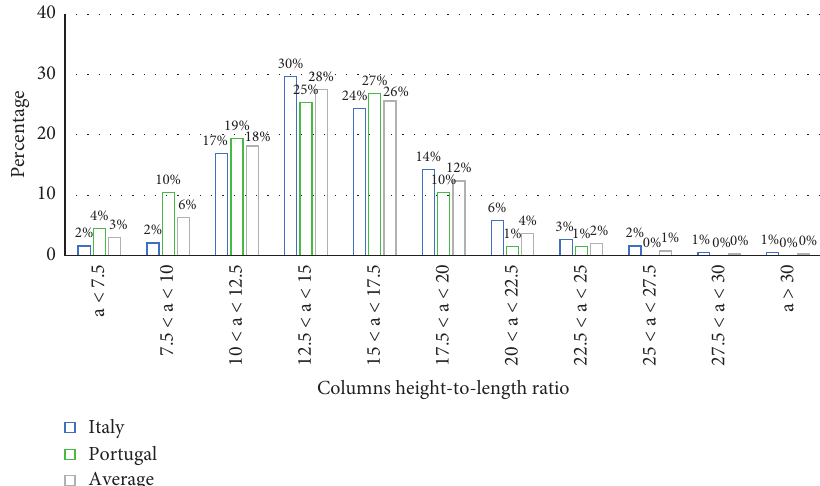
Figure 31: Comparison of height-to-width ratio of precast RC buildings in Portugal and Italy.